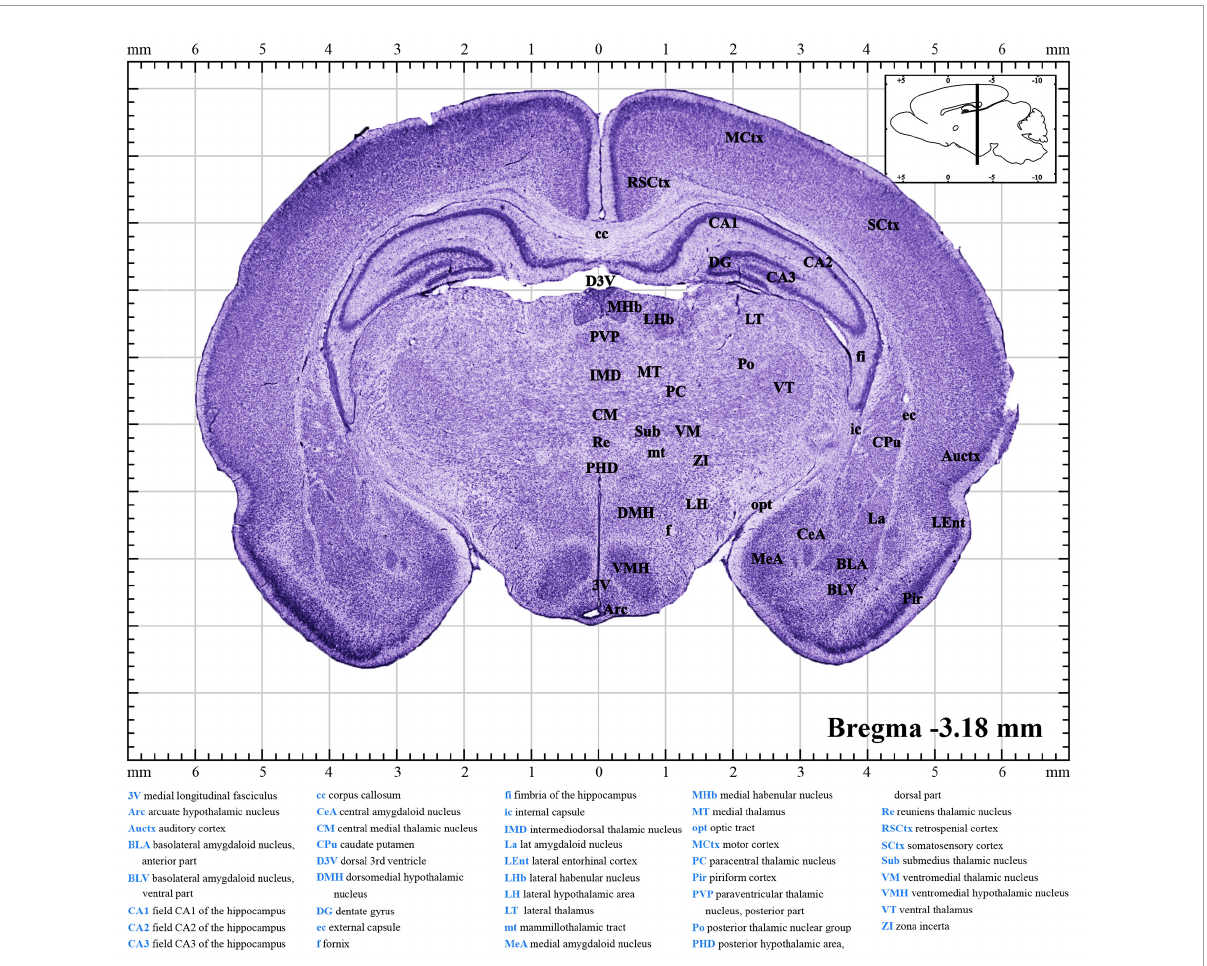
FIGURE2 A brief introduction to the atlas. A random figure of the P10 atlas ( Supplementary material 4 ) shows the anteroposterior (AP) of –3.18 mm section. The midline of the brain is defined as mediolateral (ML) of 0.00 mm, and the dorsal surface is defined as dorsoventral (DV) of 0.00 mm. The upper right inset illustrates the sagittal position (black line) of this section. Explanation of abbreviations of the main structures is at the bottom of the